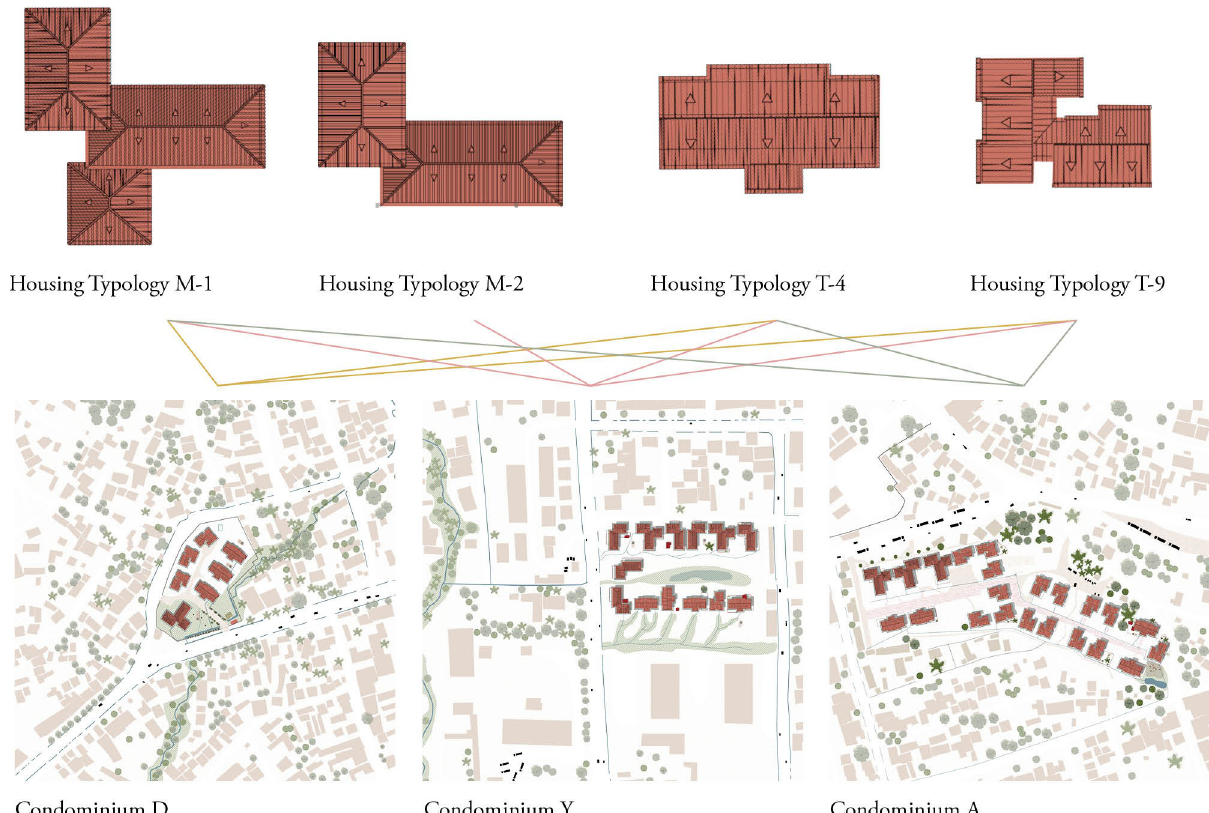
Fig 2. Condominiums and standardised housing typologies in Jimma, Ethiopia. Map drawn by the authors, based on fieldwork, https://www.usgs. gov/ and